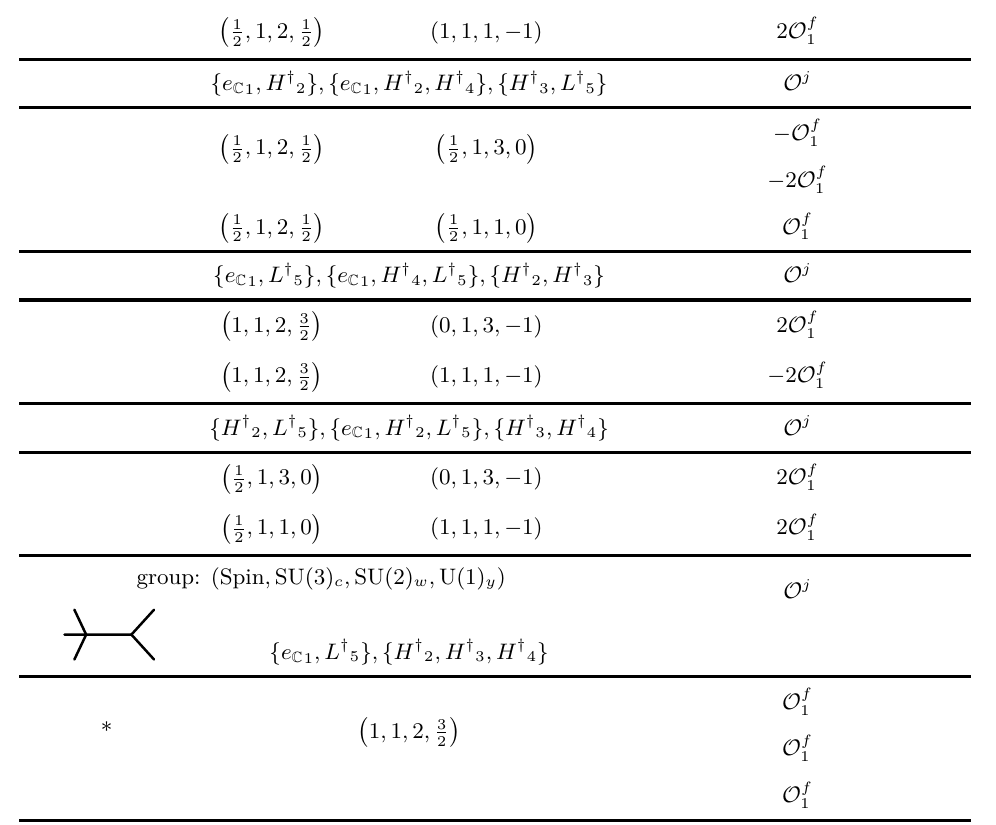
Table 26. UV resonance of topology dim7-5. “*” in front of each row indicates topologies with nonrenormalizable vertices. The UV resonances colored in gray are eliminated by UV